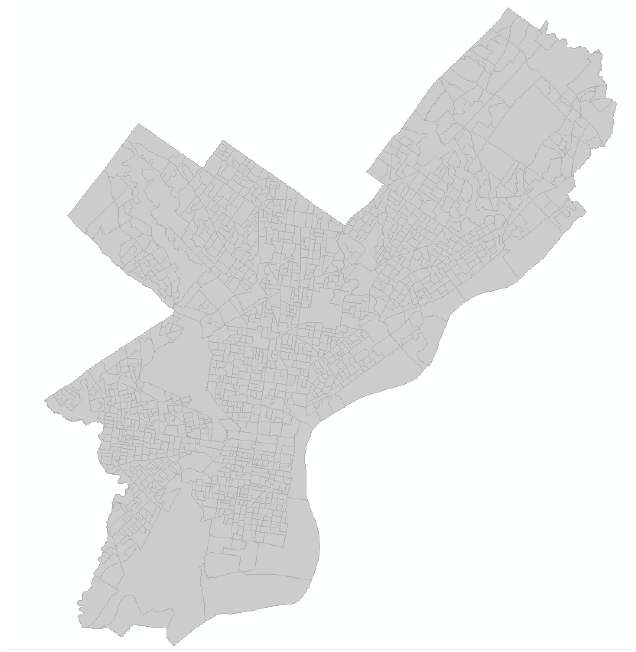
Figure 1. Map of Philadelphia by block group.